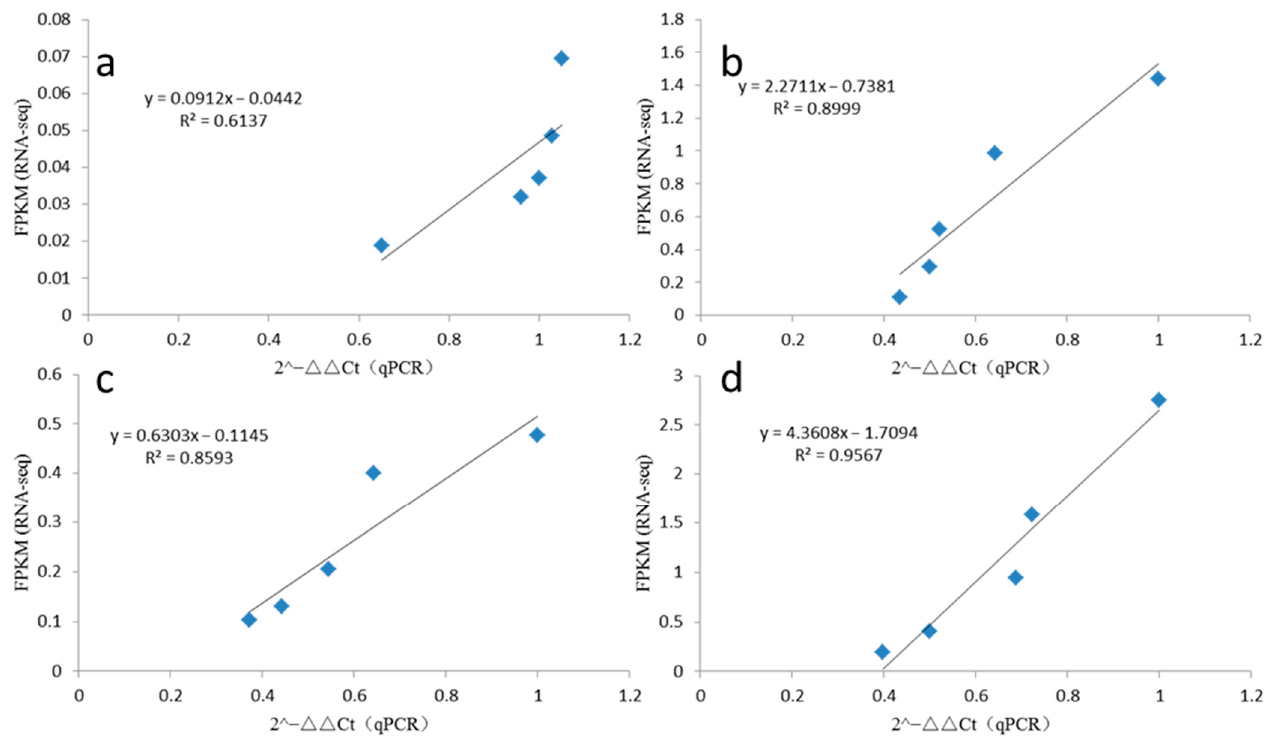
9 of 18 blue arrow: mRNAs). ( c ) Pearson correlation coefficient for expression of lncRNAs and mdm- miR482 in five tissues and functions of mRNAs. 2.8. qRT-PCR Validation